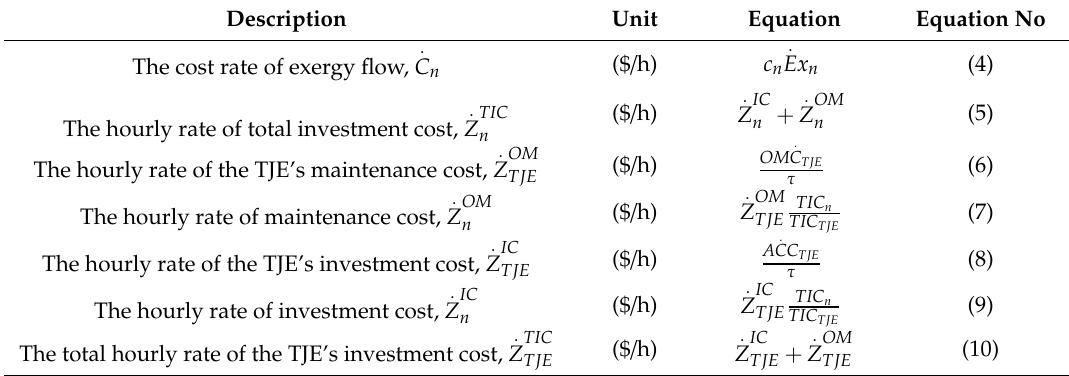
Table 1. The hourly levelized cost parameters of the TJE.